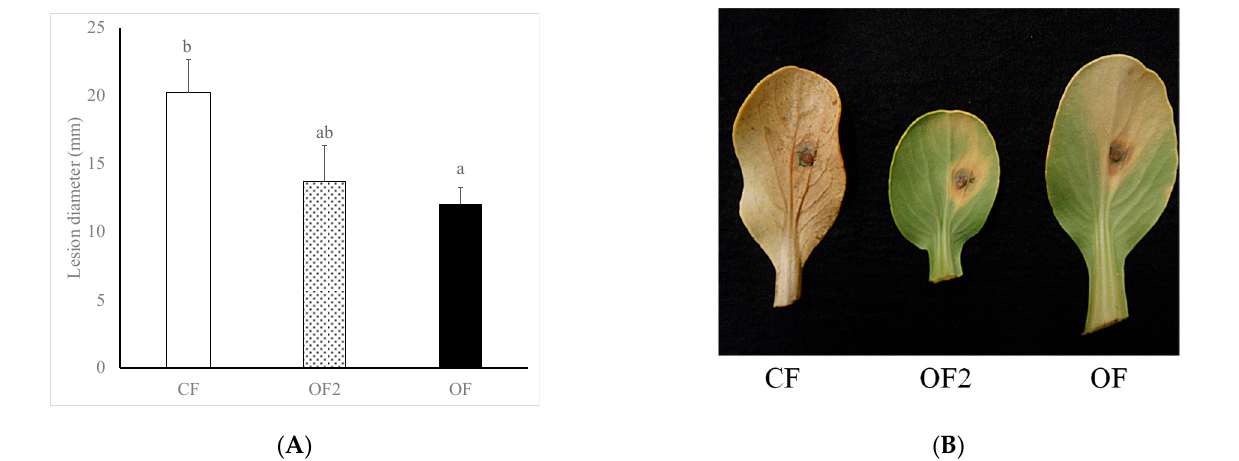
Figure 6. Effect of the different fertilizers on the induced resistance against gray mold. ( A ): Lesion diameter at five days after inoculation. Error bars on vertical columns indicate standard error ( n = 3). Identical letters between bars indicate no significant difference ( p < 0.05) among treatments according to Tukey’s multiple range test. ( B ): Gray mold lesions. OF (organic fertilizer): corn steep liquor (CSL) applied as organic fertilizer at the same amount of total nitrogen as that in the half unit of Otsuka A formula; OF2: CSL applied at twice the amount of total nitrogen in OF; CF (chemical fertilizer): half unit of Otsuka A formula.